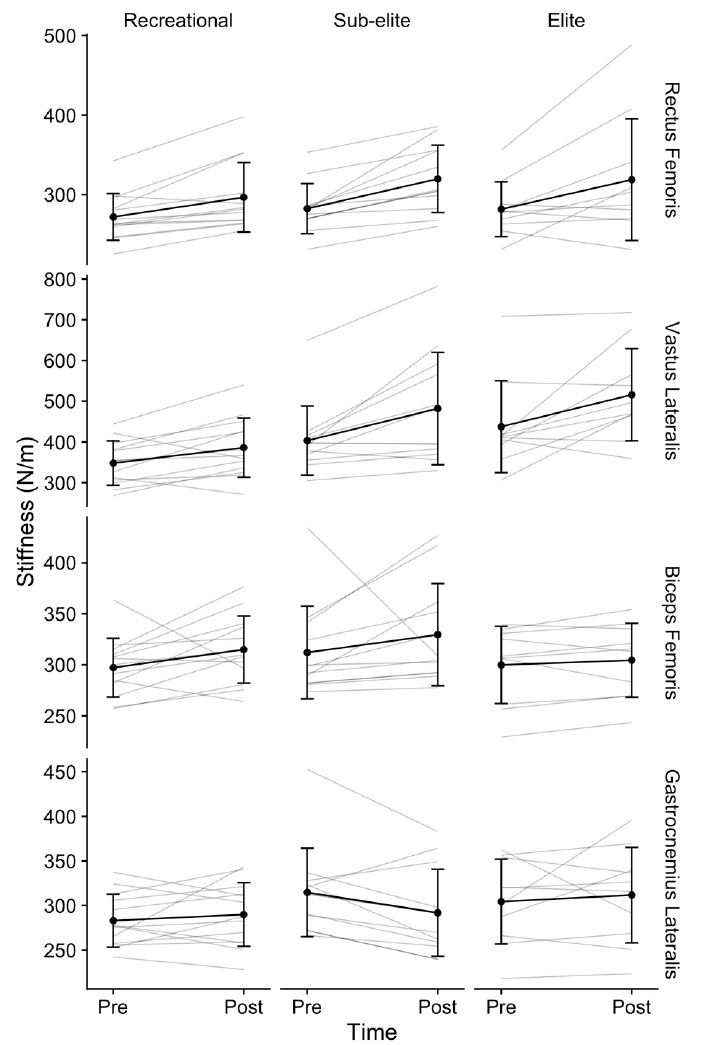
Figure 2. Stiffness by group, muscle, and time. Dots indicate group means whereas vertical error bars indicate standard deviations for each mean.